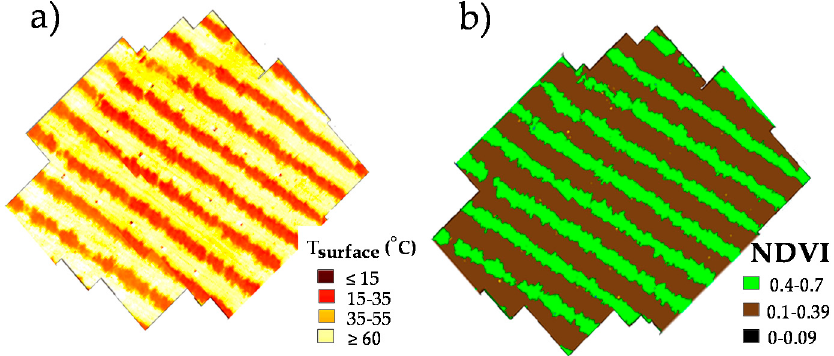
Figure 3. ( a , b ) Averaged spatial distribution of the normalized difference vegetation index (NDVI) and surface temperature (Tsurface) over a drip-irrigated olive orchard using multispectral and thermal cameras, respectively, placed aboard an unmanned aerial vehicle (UAV).